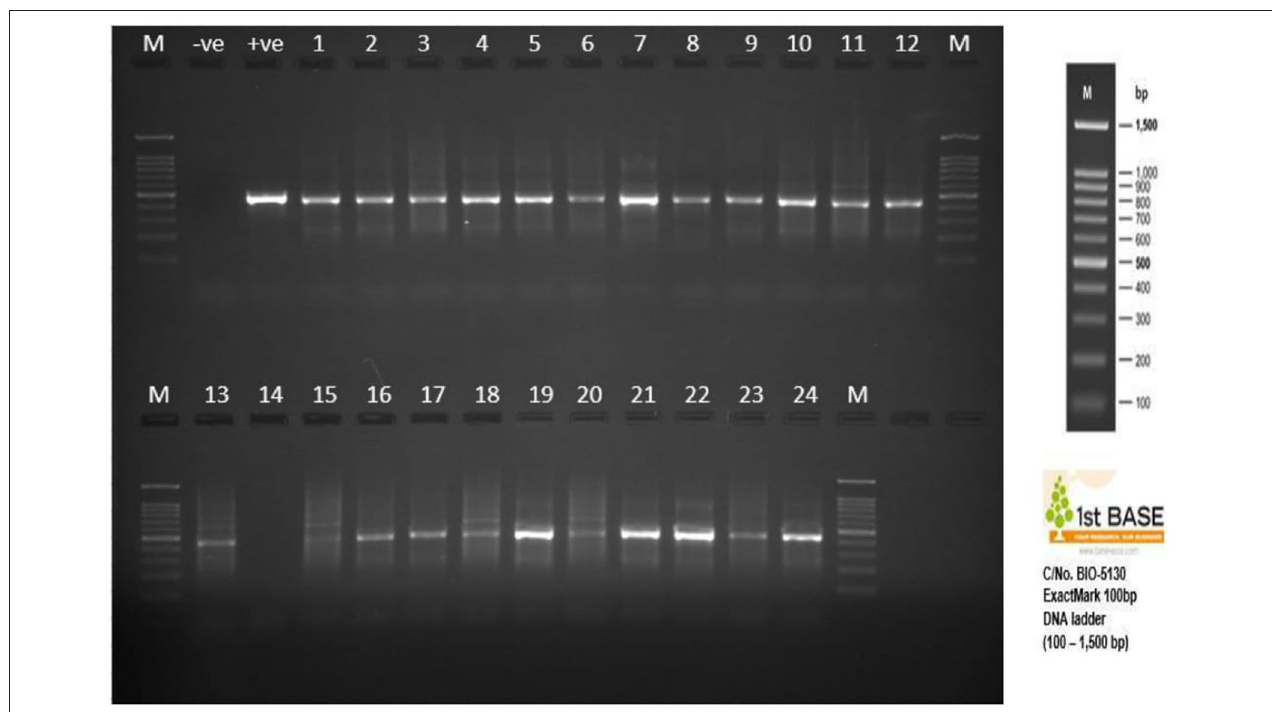
FIGURE 1 | Bacterial gDNA fluorometric